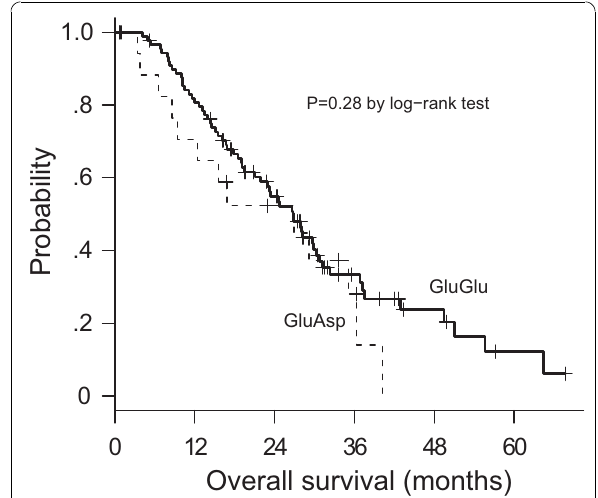
Figure 2 Kaplan-Meier plot of overall survival in relation to the G894T genotype in exon